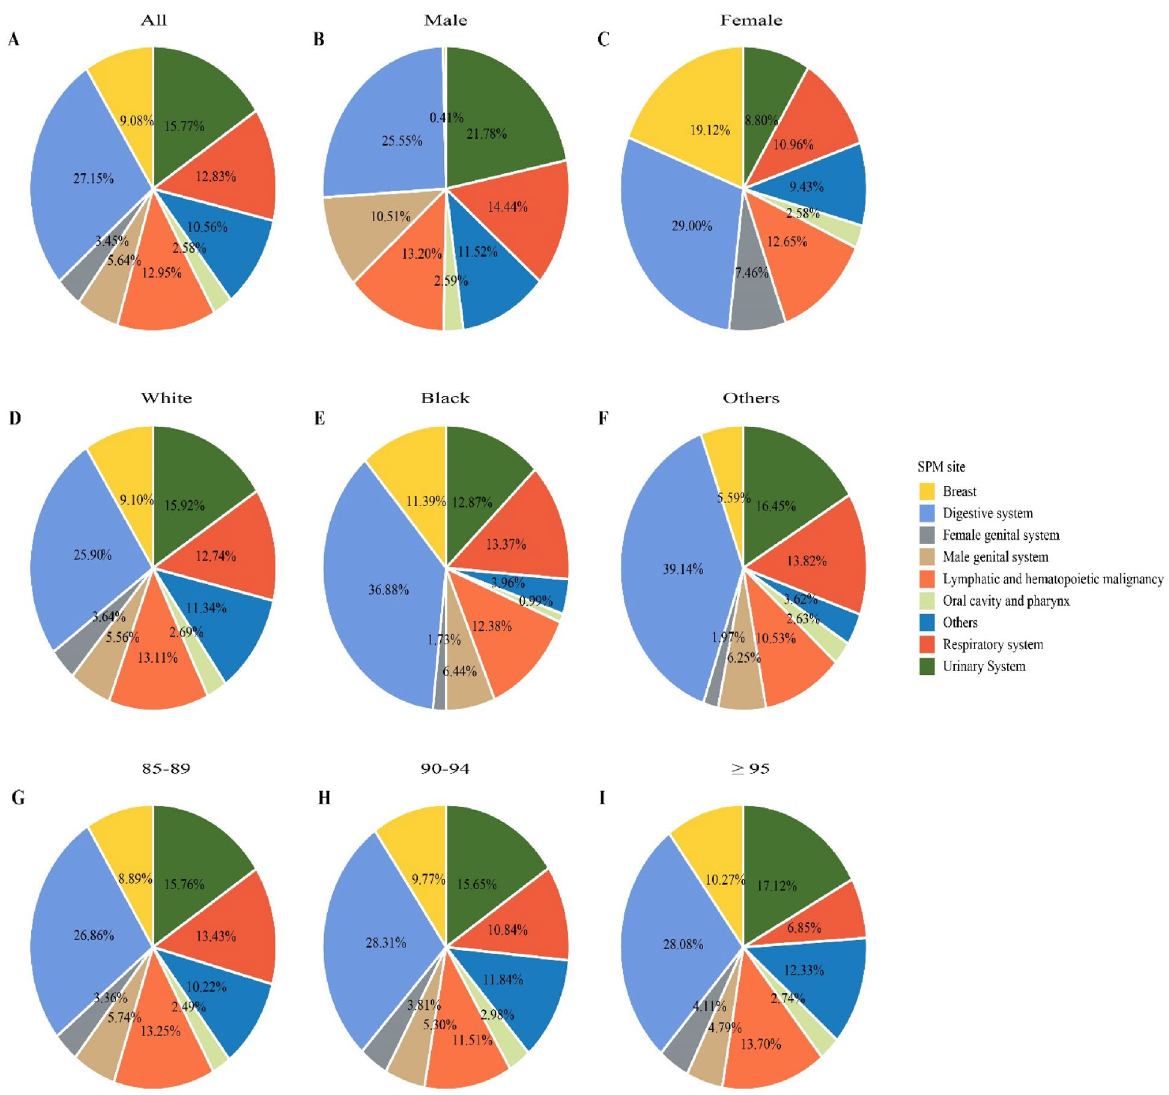
Figure 2. Distribution of SPM sites. ( A ) all, ( B ) male, ( C ) female, ( D ) white race, ( E ) black race, ( F ) other races, ( G ) age 85–89 years, ( H ) age 90–94 years, and ( I ) age ≥ 95 years. SPM second primary